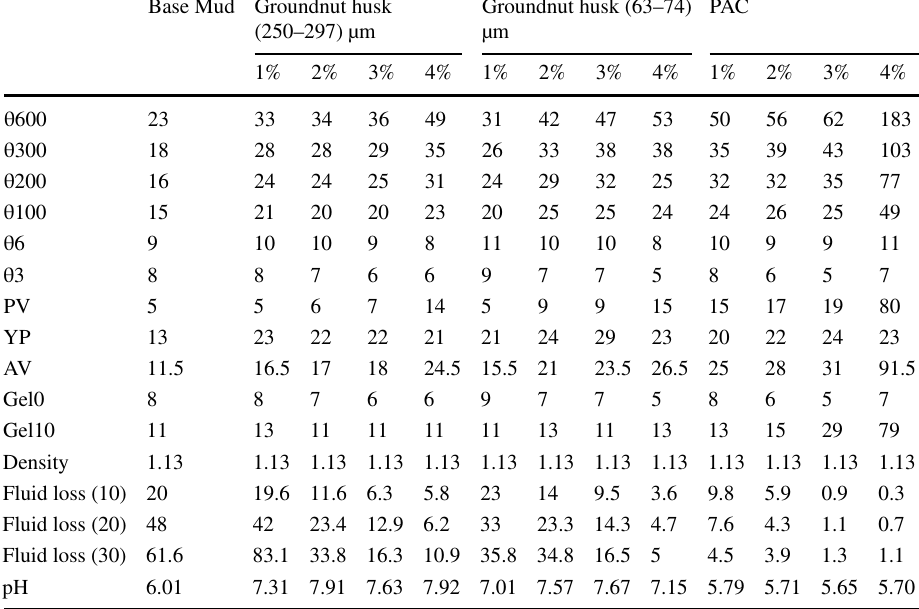
Table 3 Readings of various rheological properties of the developed drilling fluid formulations taken after the hot